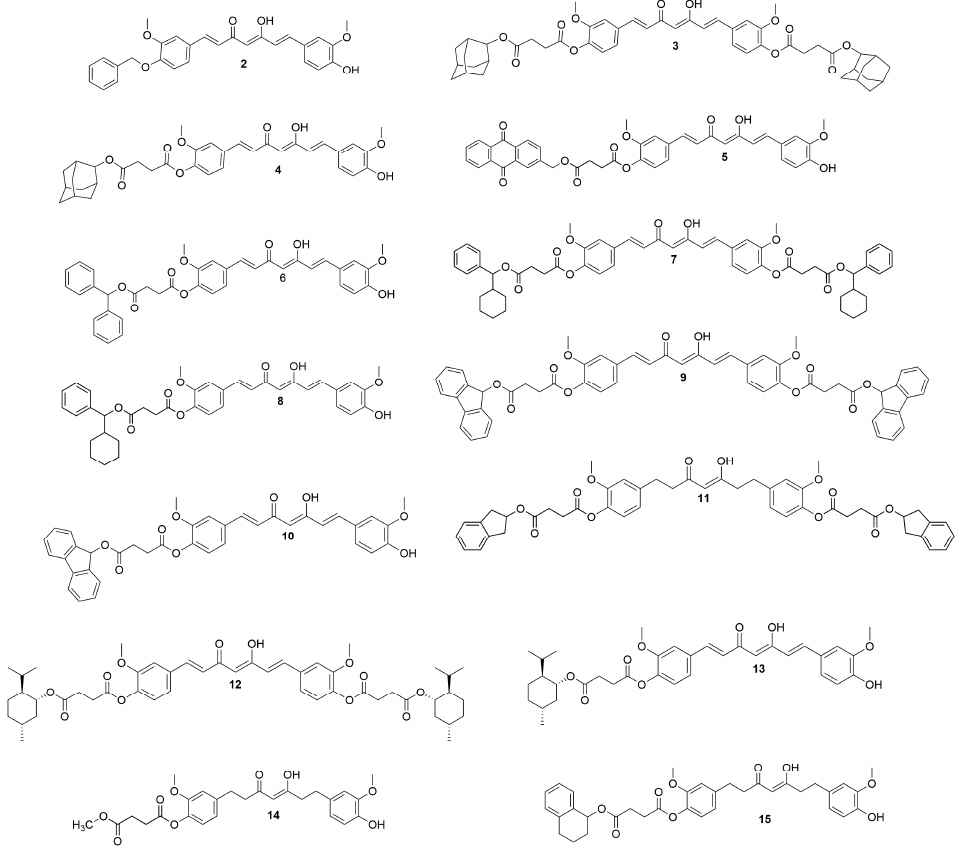
Figure 2. Curcumin derivatives to determine their anti-inflammatory activity.